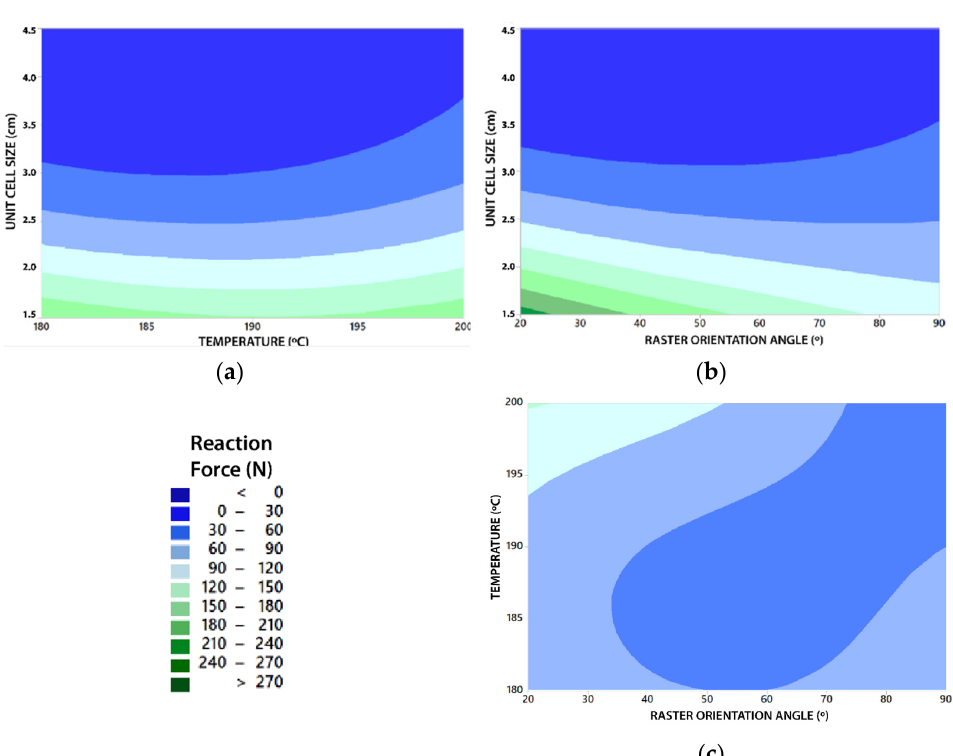
Figure 9. Main effects graph.